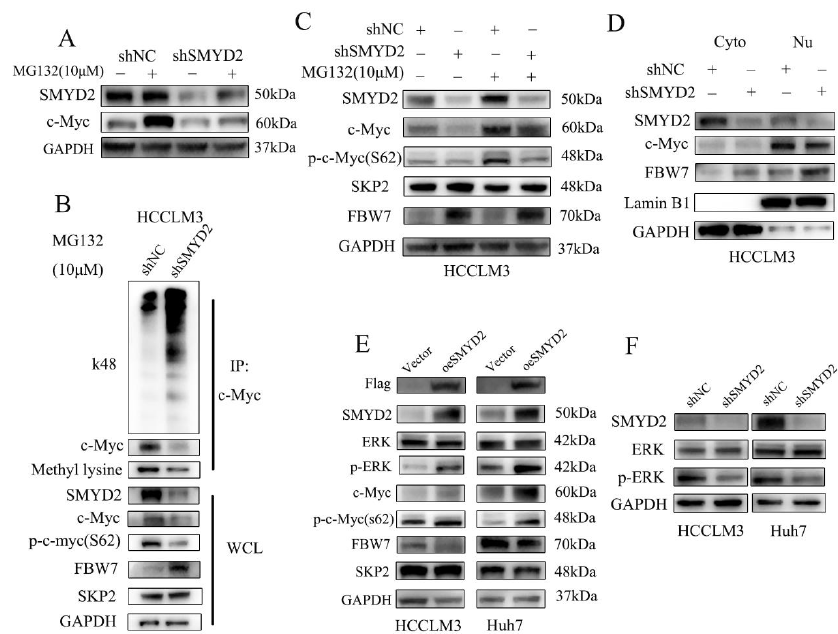
Figure 5. SMYD2 protects c-Myc protein from ubiquitination and degradation. ( A ) The effects of MG132 on c-Myc expression in SMYD2 knockdown HCCLM3 cells were determined using Western blot. The indicated cells were treated with MG132 (10 μ M) for 4 – 6 h. ( B ) Immunoprecipitation (IP) was performed to detect the methylation and K48 polyubiquitination level of c-Myc in HCCLM3- shSMYD2 and HCCLM3-shNC cells. After exposing to MG132 (10 μ M) for 4 – 6 h, extracts were used to IP with c-Myc antibody. ( C ) Effects of MG132 on SKP2, p-c-Myc(S62), FBW7 and c-Myc in SMYD2 knockdown cells. ( D ) Cytoplasmic and nuclear FBW7 and c-Myc expression were examined in HCCLM3-shSMYD2 and HCCLM3-shNC cells. Lamin B1 and GAPDH were selected as internal standards. Nu: nucleus. Cyto: cytoplasm. ( E ) Influence of overexpressed SMYD2 on the indicated proteins in HCCLM3 and Huh7 cells. ( F ) The effect of SMYD2 knockdown on p-ERK in indicated cells.